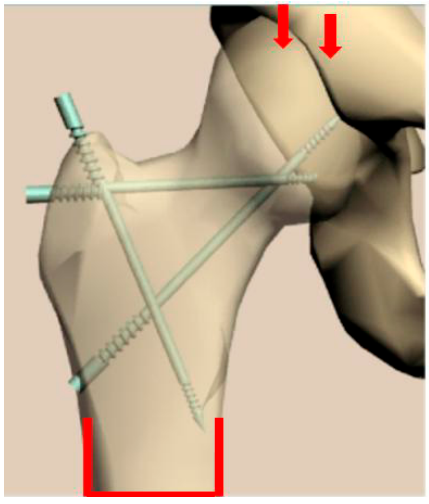
Figure 9. The image of the hip after the insertion of reinforcing implants.